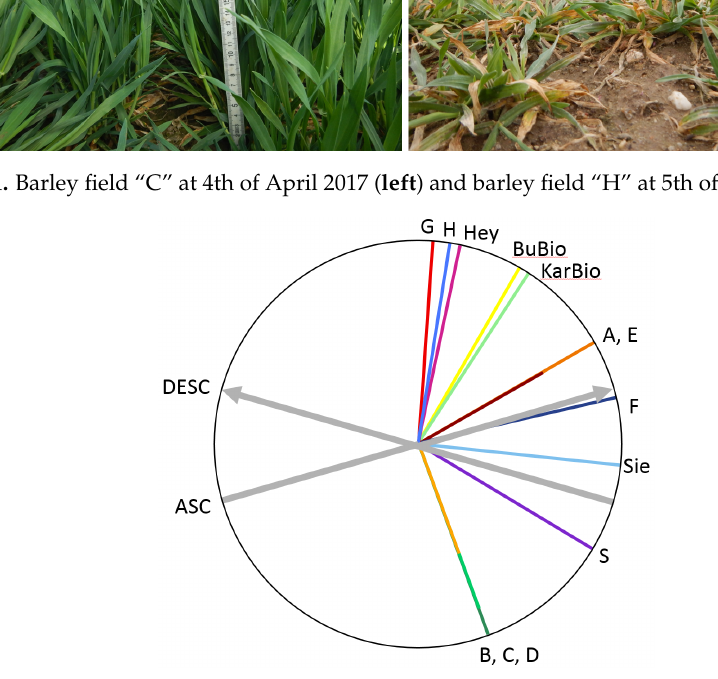
Figure 12. Row orientation of all observed field compared to the looking direction of the sensor in ascending and descending